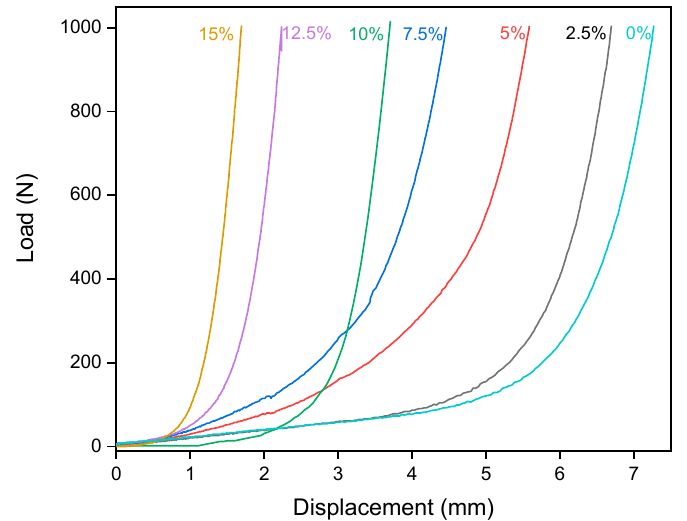
Figure 3. Squeeze flow results for different mixtures.